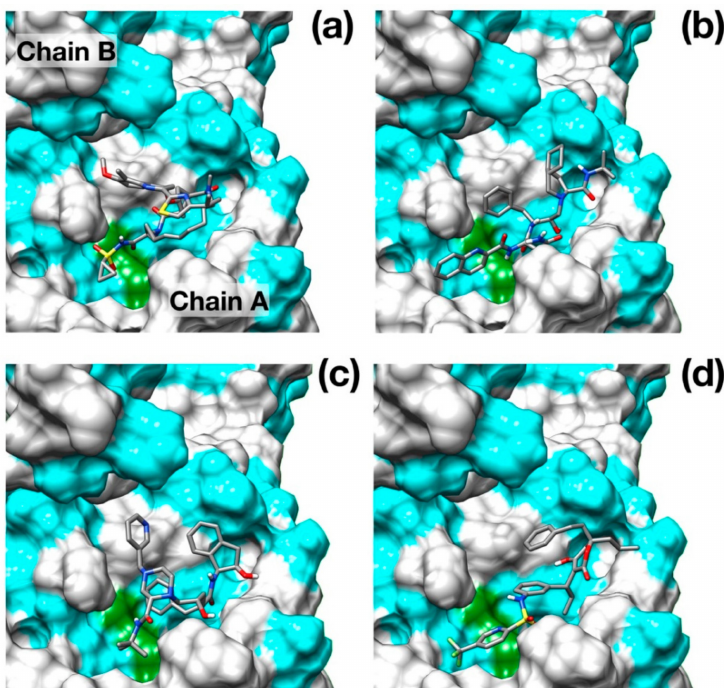
Figure2. Bindingposesofthebestscoringdockedinhibitors.( a )Simeprevir; ( b )Saquinavir; ( c )Indinavir; ( d ) Tipranavir. Hydrophobic residues (Ala, Phe, Leu, Ile, Pro, Tyr, Val, Met, Trp, Gly) are colored in cyan. Catalytic residues are colored in green. N, O, C and S atoms are colored in blue, red, gray and yellow